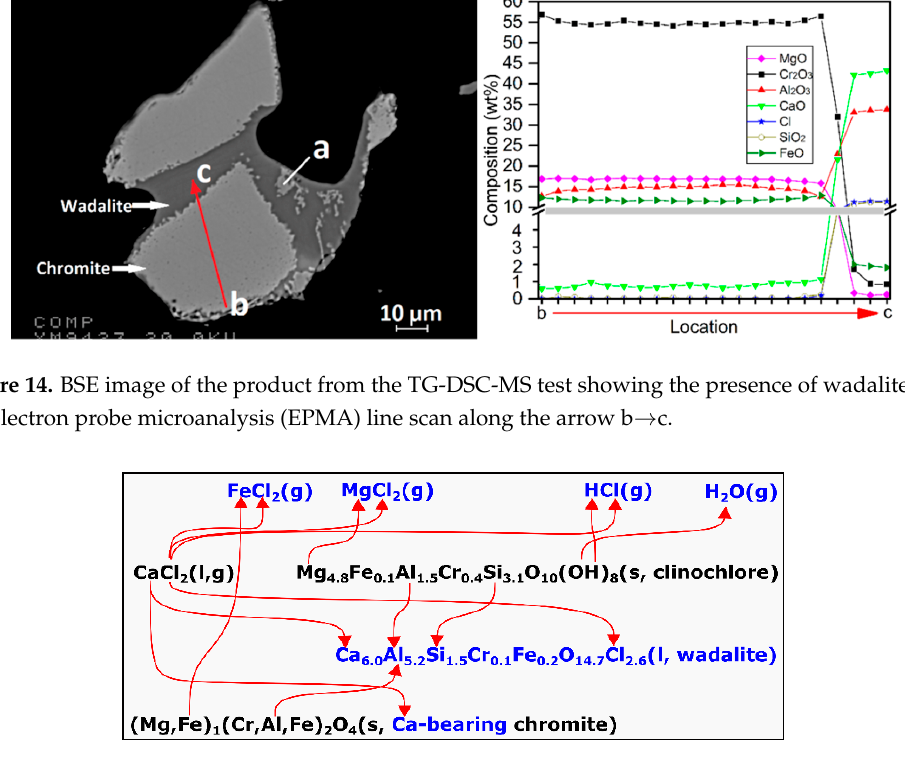
Figure 15. Illustration of the proposed interactions among CaCl 2 , clinochlore, and chromite.